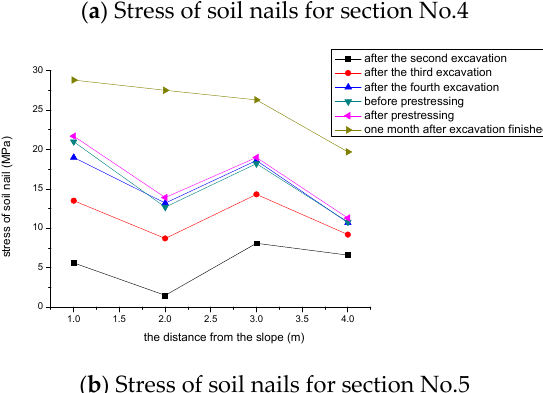
after the second excavation after the third excavation after the fourth excavation before prestressing after prestressing one month after excavation finished